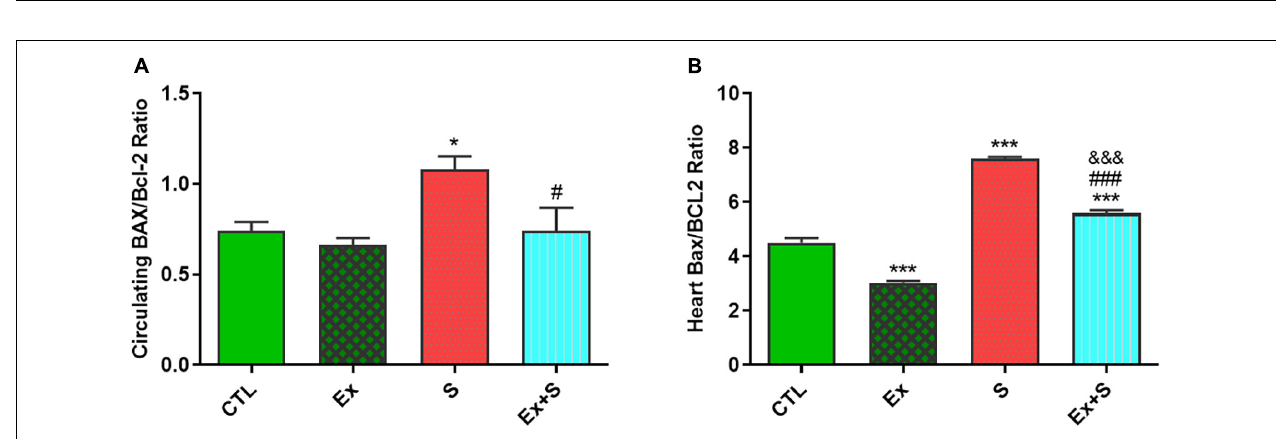
FIGURE 8 | Effects of waterpipe smoke inhalation on Bax/Bcl-2 ratio in serum (A) and in the heart (B) in experimental groups. CTL, control group; Ex, group subjected to exercise training for 8 weeks; S, group subjected to waterpipe tobacco smoke inhalation for 8 weeks; Ex + S, group subjected to exercise training and waterpipe tobacco smoke inhalation for 8 weeks. The results are presented as mean ± SEM, n (6–7). * P < 0.05, *** P < 0.001 vs. CTL; # P < 0.05, ### P < 0.001 vs. S; &&& P < 0.001 vs. Ex.